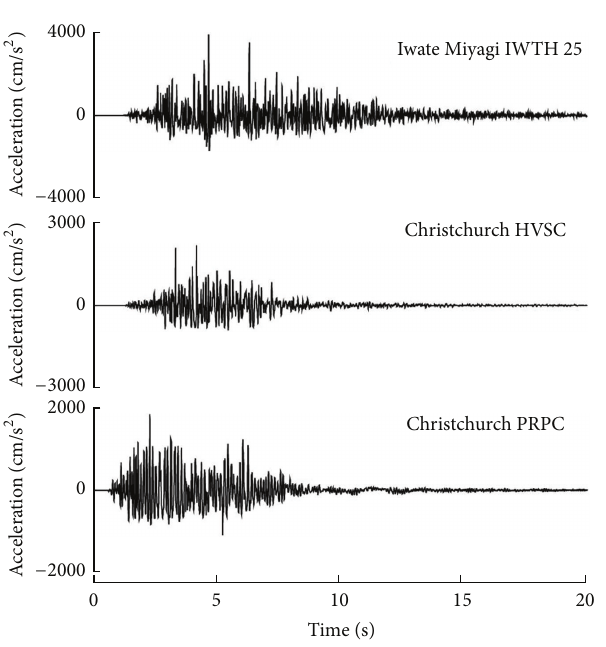
Figure 13: Acceleration waveforms of large amplitude.